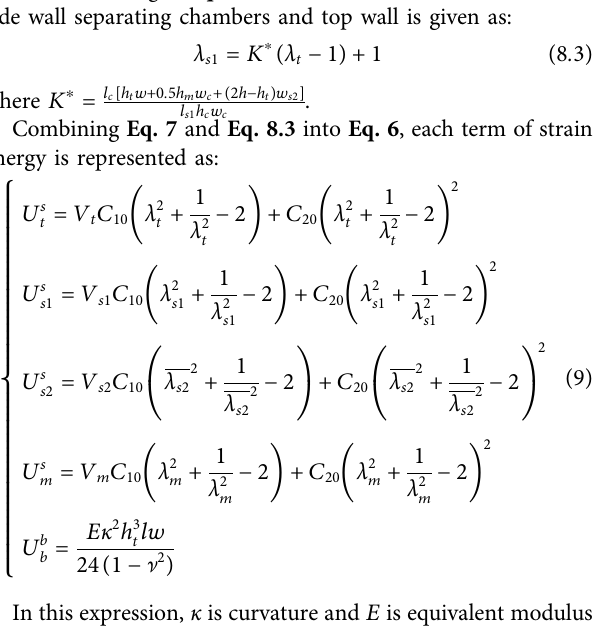
Frontiers in Mechanical Engineering |